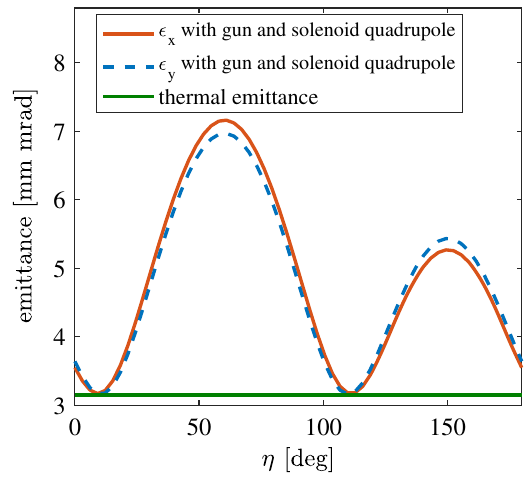
FIG. 5. Emittance at Position 2 based on the realistic rf gun (includes quadrupole) and solenoid (includes quadrupole) as a function of the rotation angle of the solenoid